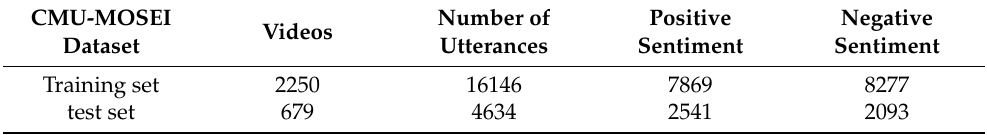
Table 1. Training set and test set of the CMU-MOSEI dataset.